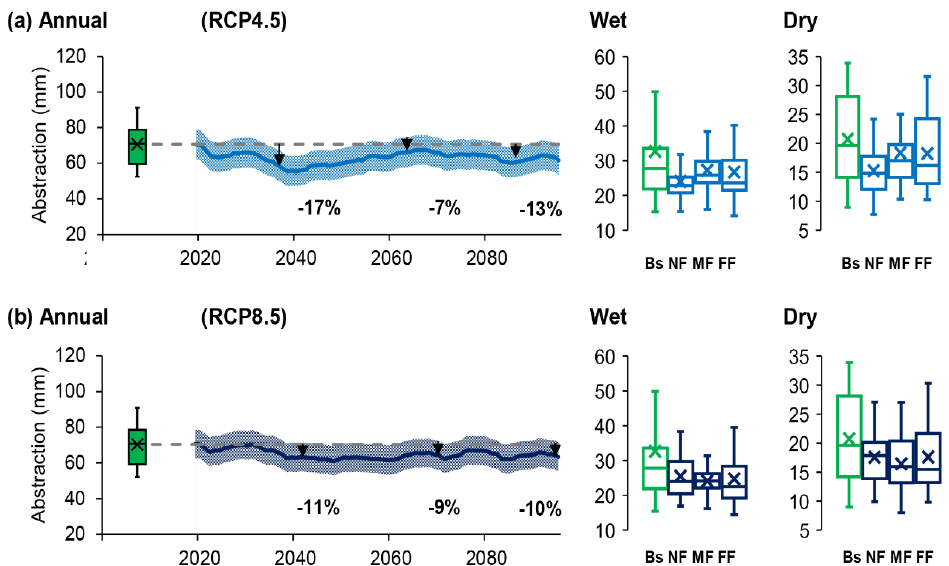
Figure 5. Annual and seasonal projections of groundwater abstraction in the agricultural areas of Lahore, under the ( a ) RCP4.5, and ( b ) RCP8.5 climate change scenarios for the 21st century. The shaded area in annual graphs represents the 25th and 75th percentile, and smooth lines are twenty years moving averages. All abstraction changes are significant at p = 0.05.